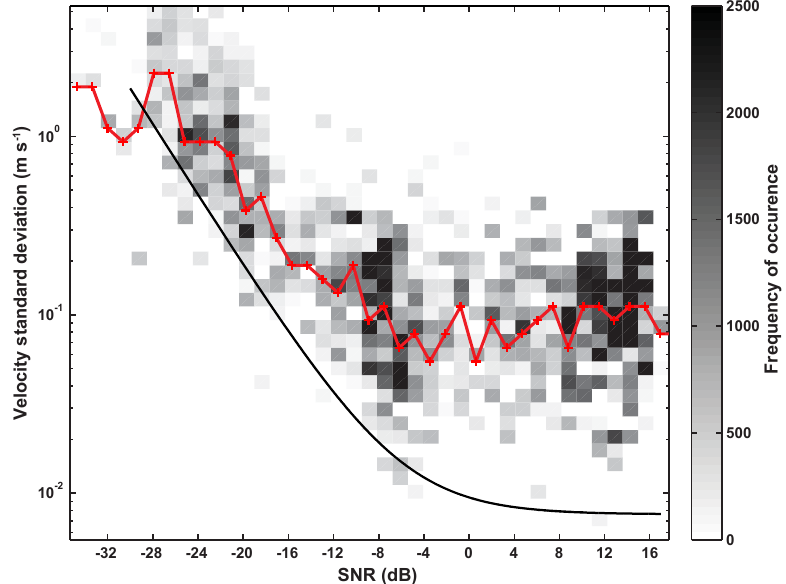
Figure 8. Standard deviations of the Doppler horizontal velocity determined from the zero lag impulse in the auto-covariance and the theoretical standard deviation (black line) for a signal spectral width of 2ms − 1 . The median standard deviation per SNR bin is shown as a red line.